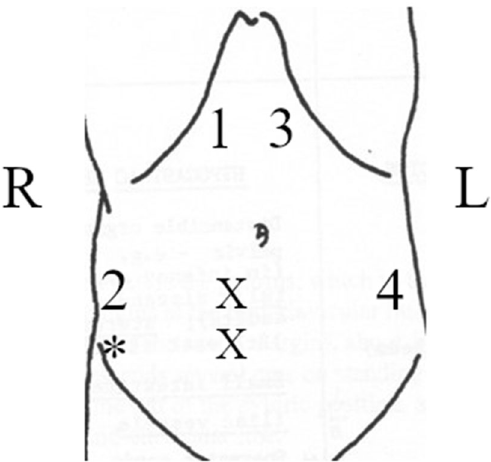
Figure 1. Idealised placement of MC and EMG sensors on the abdomen. Numbers 1–4 represent the placement of MC sensors; US measurements were conducted at 1. The double X shows the placement of both EMG electrodes. * shows the placement of the EMG ground